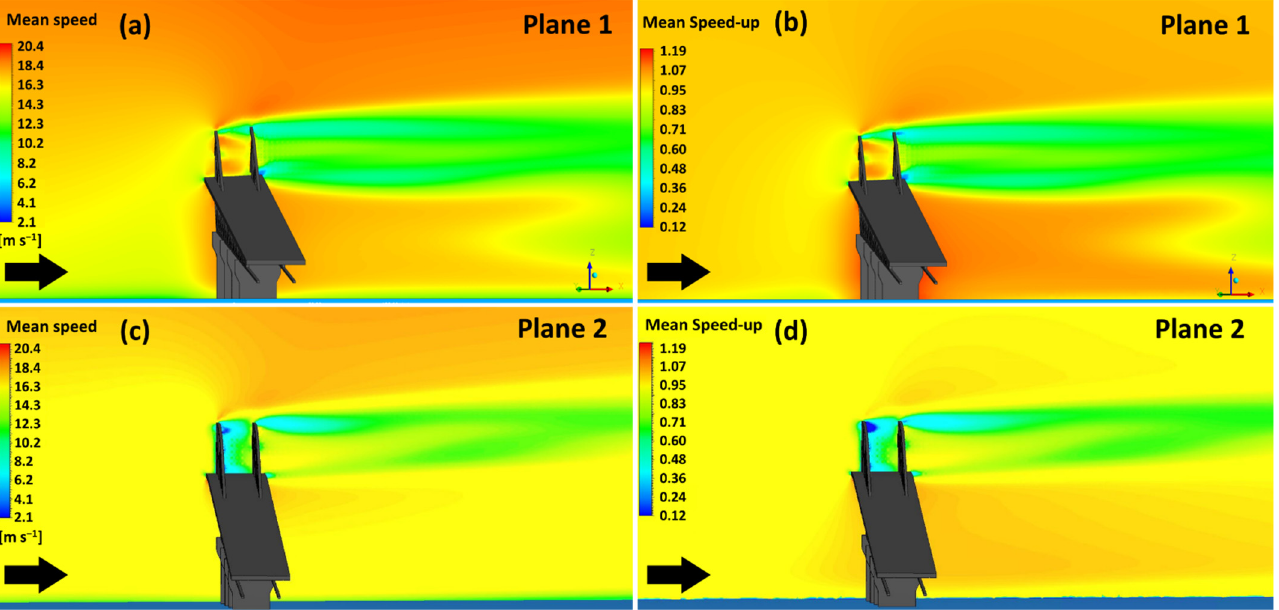
Figure 8. Two cross-sectional planes selected to present the wind speed results.